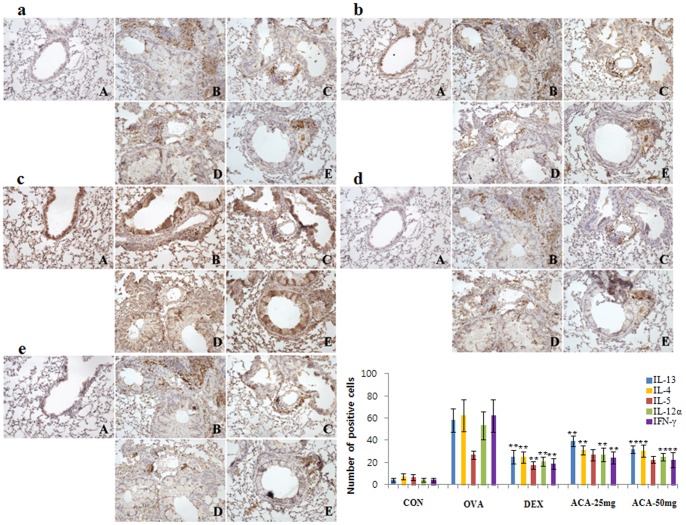
ACA reduced expression of Th2 and Th1 cytokines in OVA-induced asthma.Treatment with ACA reduced (a) IL-13 expression and (b) almost completely blocked IL-4 expression in the lungs. (c) ACA also decreased IL-5 expression but to a lesser extent. (d) ACA almost completely blocked IL-12α expression and (e) downregulated IFN-γ expression. Immunopositive cells were counted in five randomly selected nonoverlapping fields (×200 magnification) of three separately immunostained lung sections per each animal. A, vehicle control; B, OVA-induced asthma model; C, dexamethasone; D, 25 mg/kg/day ACA; E, 50 mg/kg/day ACA. Results are expressed as mean ± SD (n = 7 per group);*p<0.05 and **p<0.01 vs. OVA group.